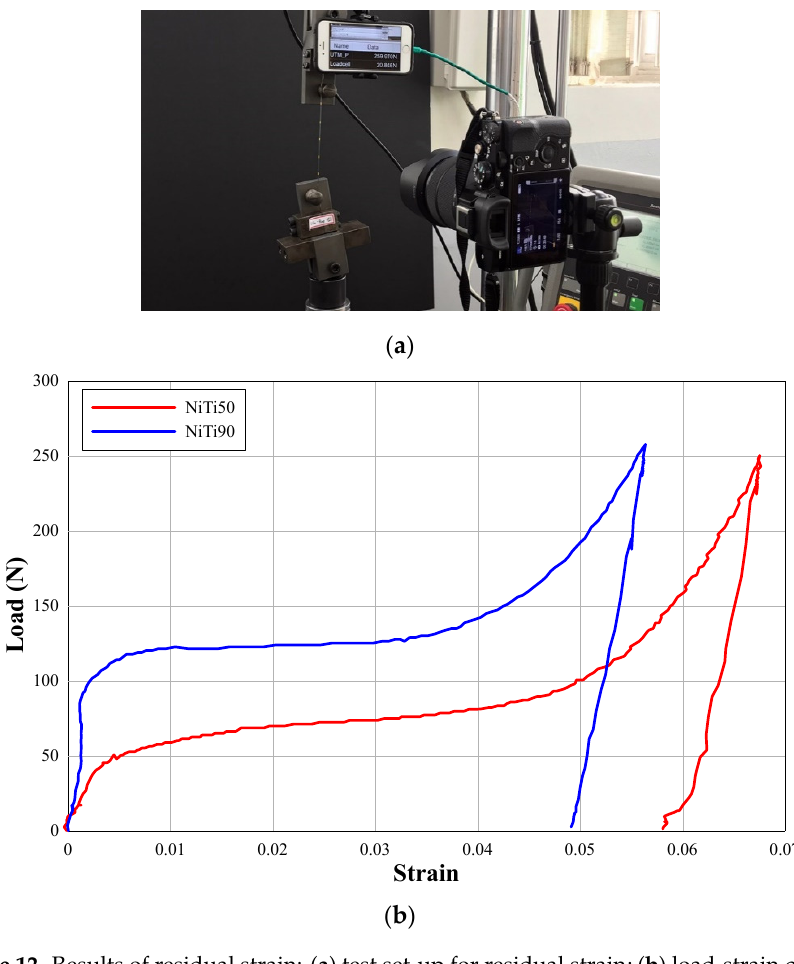
Figure 12. Results of residual strain: ( a ) test set-up for residual strain; ( b ) load-strain curves.